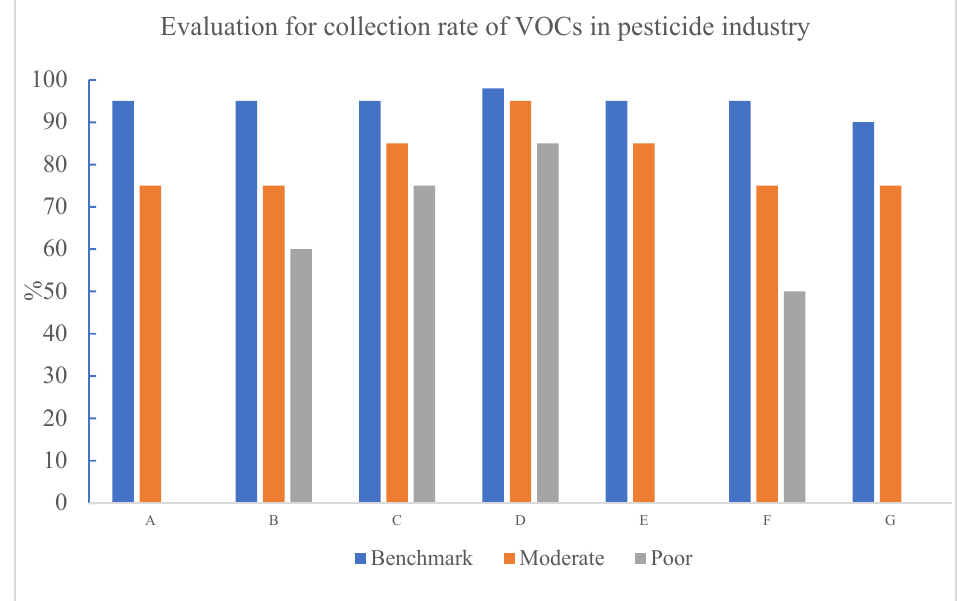
Figure 4. Evaluation for collection rate of VOCs in pesticide industry. (A: preparation, feeding, and